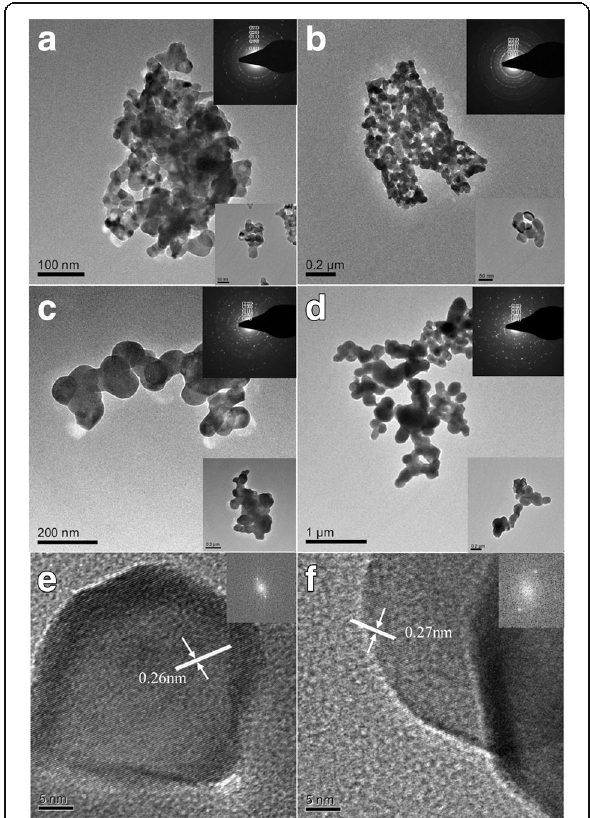
Fig. 3 TEM images of the (La 0.6 Pr 0.4 ) 0.67 Ca 0.33 MnO 3 nanoparticles post-annealed at a 700 °C, b 800 °C, c 900 °C, and d 1000 °C for 5 h. Insets in ( a – d ) are the corresponding selected area electron diffractions taken from lots of (La 0.6 Pr 0.4 ) 0.67 Ca 0.33 MnO 3 nanoparticles, respectively. The indices are labeled based on the pseudo-cubic perovskite structure. e – f HRTEM images of the (La 0.6 Pr 0.4 ) 0.67 Ca 0.33 MnO 3 nanoparticle post-annealed at 700 and 900 °C for 5 h. Inset is the FFT pattern of the HRTEM images